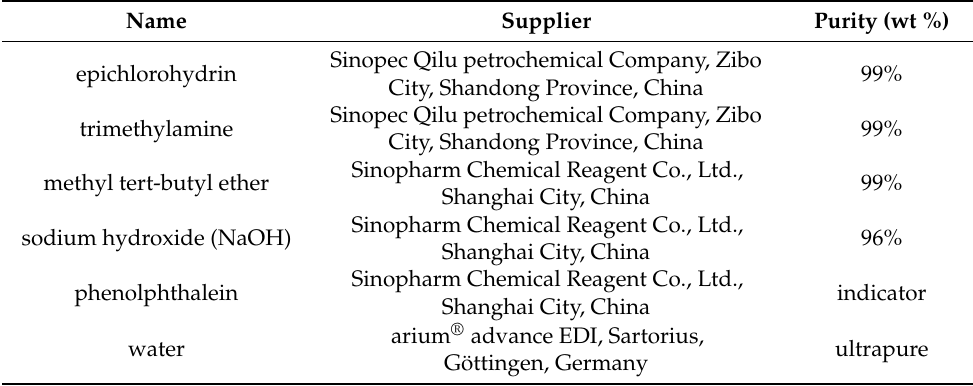
Table 1. Details of materials used in this